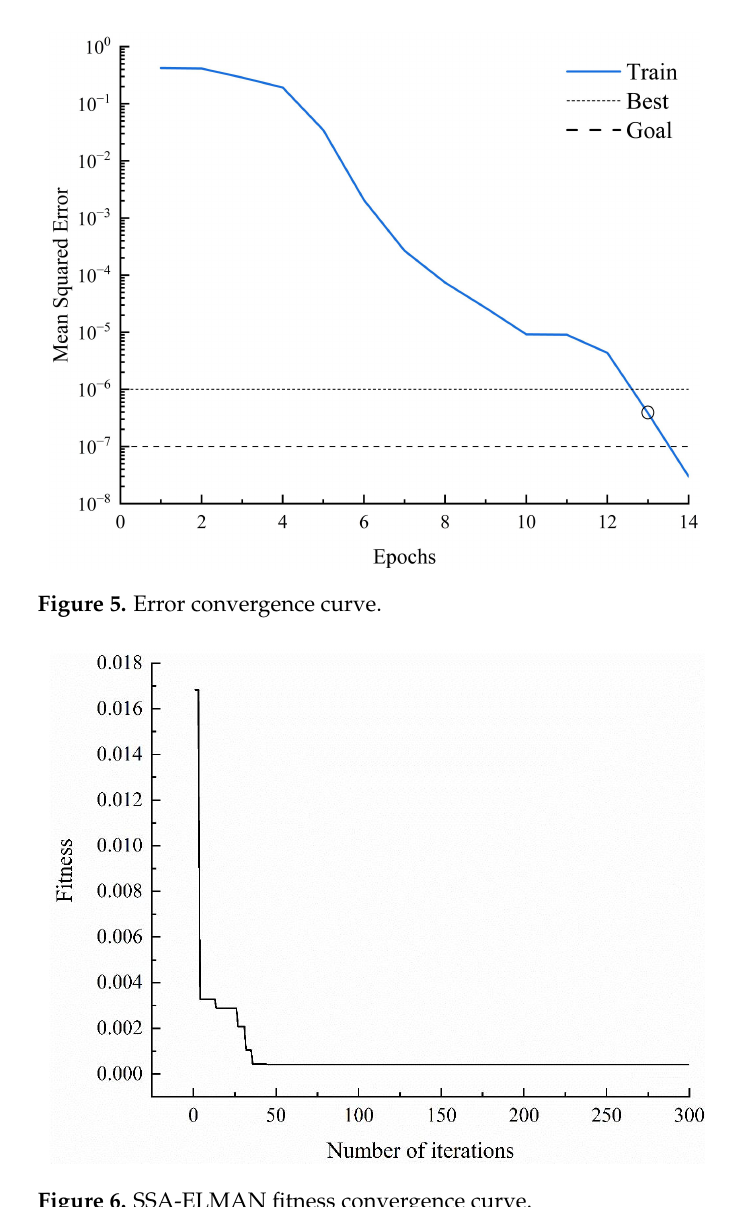
Figure 6. SSA-ELMAN fitness convergence curve.